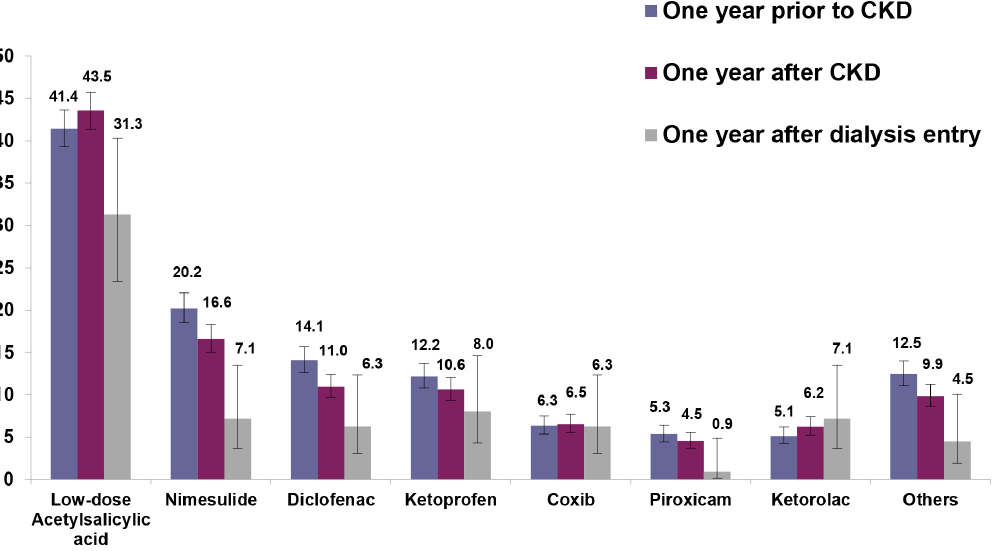
Figure 5. Proportion of CKD patients (N=1,989) who received $ 1 prescription of NSAIDs. Proportion of CKD patients (N=1,989) who received at least one prescription of individual NSAIDs within one year prior or after the first CKD diagnosis and within one year after the entry in dialysis (N=112). Others ( , 5%): tenoxicam, meloxicam, aceclofenac, ibuprofen, dexibuprofen, tiaprofenic acid, naproxen, lornoxicam, acetylsalicylic acid, acetylsalicylic acid and ascorbic acid, niflumic acid, diclofenac sodium plus misoprostol. Coxib: celecoxib, etoricoxib.